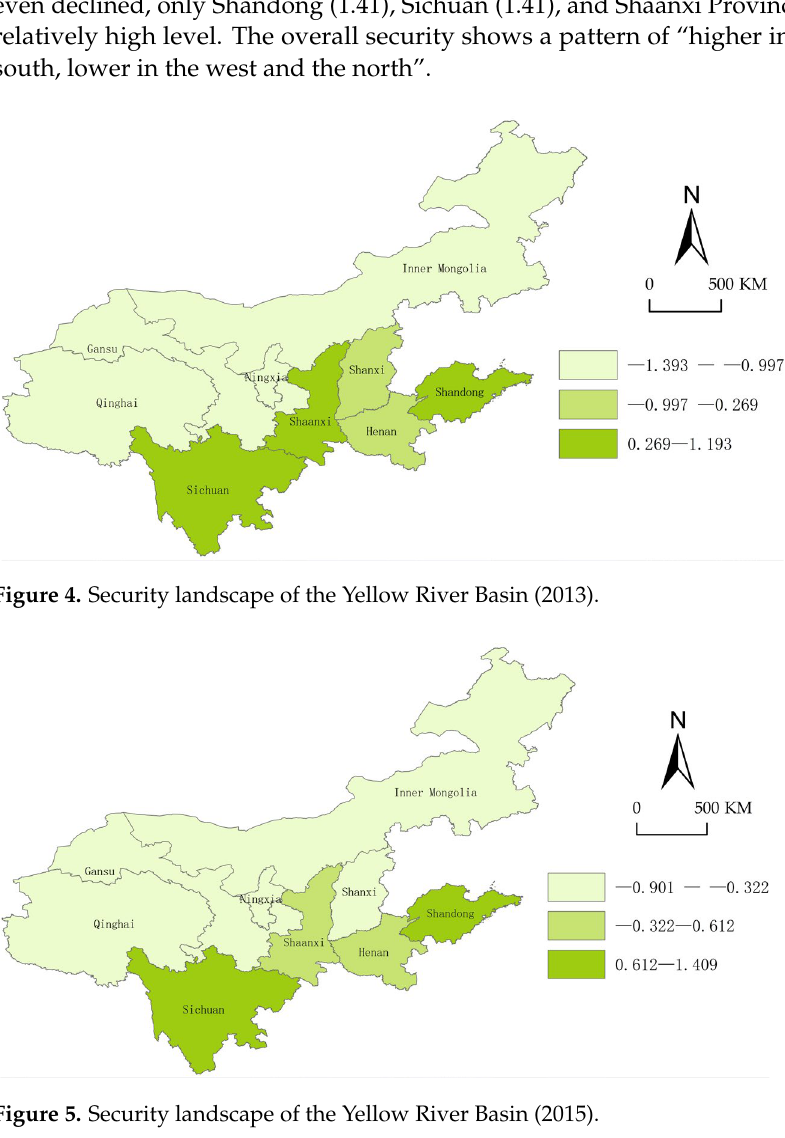
Figure 7. Security landscape of the Yellow River Basin (2019). The reason is that Shandong Province is located in the Bohai Sea Port, with a high degree of openness, and thus the level of economic development is far ahead of other provinces. Shandong has many innovation subjects, and its innovation resources are more concentrated, the innovative landscape is relatively perfect so that new ideas, new tech- nologies, and new products can smoothly move from the laboratory to the market. Alt- hough Shaanxi and Sichuan are located in the west of China and the degree of openness is relatively low, at the same time the development environment is relatively poor, both of them have a high-security degree. The reason is that there are a large number of uni- versities, scientific research institutions, rich reserves of innovative talent resources, inter- mediary service institutions, and a relatively complete innovation infrastructure. How- ever, Qinghai Province and Ningxia are located in the hinterland of northwest China, the economic development conditions are relatively harsh, there are fewer innovation sub- jects, and the construction of innovative landscapes is not perfect enough, coupled with China’s strategic positioning as “ecological protection main functional area”, the safety improvement of innovative ecosystem is not so obvious. (2) Spatial correlation analysis To further explore whether there is a spatial correlation among the security of inno- vative ecosystems in the Yellow River Basin, this paper uses GeoDa [34] to test the global Moran for the index, and the results show that: